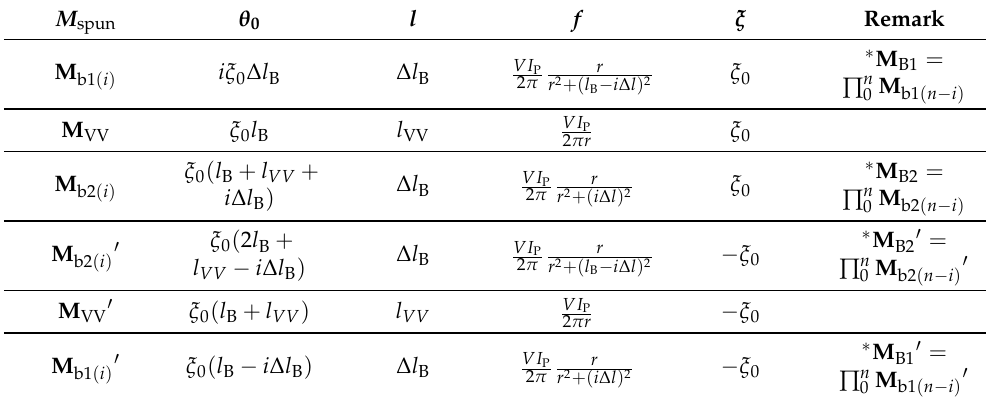
Table 1. Spun fiber matrices for each section consisting of the spun fiber parameters ( θ 0 , l , f , and ξ ). M spun θ 0 l f ξ M b1 ( i ) i ξ 0 ∆ l B ∆ l B M VV ξ 0 l